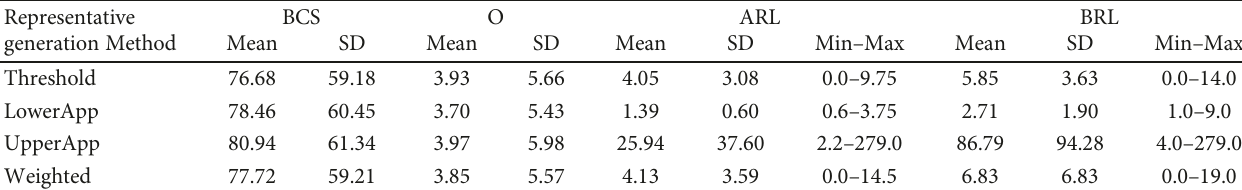
Table 3: The quality of rules clusters vs. representative generation methods.